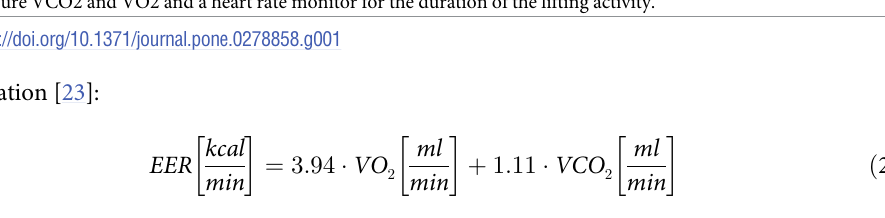
Fig 1. Geometrical setting for experiment. Subjects stood in front of a 27.5 pound box (10”x10”x10”) and moved it from the floor to the 30” high table, and from the table to the floor at a frequency of six lifts per minute for 20 minutes. The hand grasps of the box were 10” away from the midpoint of the subject’s ankles and 5” from the floor. A ‘freestyle’ lifting technique was allowed. The subject wore a mask that connected to the CardioCoachCO2 metabolic cart to measure VCO2 and VO2 and a heart rate monitor for the duration of the lifting activity.